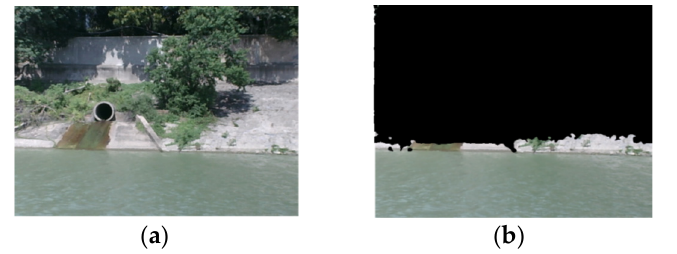
Figure 7. Deletion of non-water regions in the left image: ( a ) original image; ( b ) water image data.